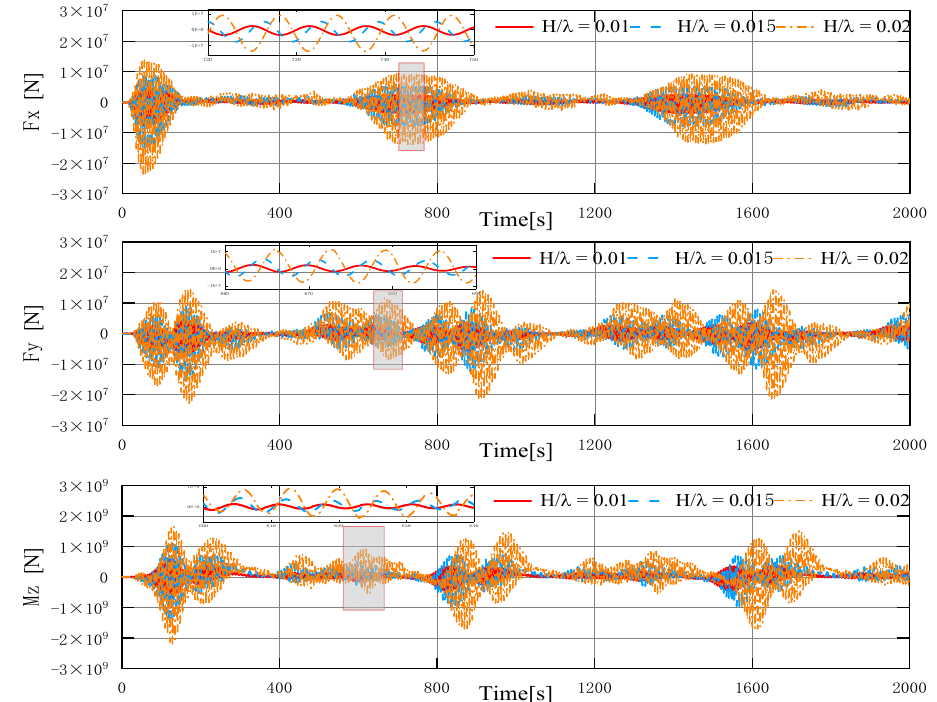
Figure 28. The time history of the surge, sway, and yaw wave drift forces and moment of the KVLCC2 under −35° turns with a variation of the wave steepness in the head waves.